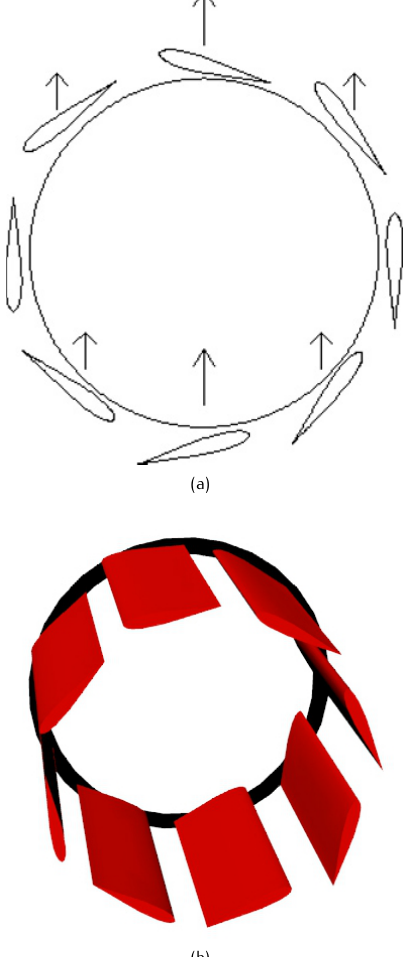
Figure 3. Cycloidal rotor for propulsion: a) section of the cycloidal rotor; b) 3D view of the